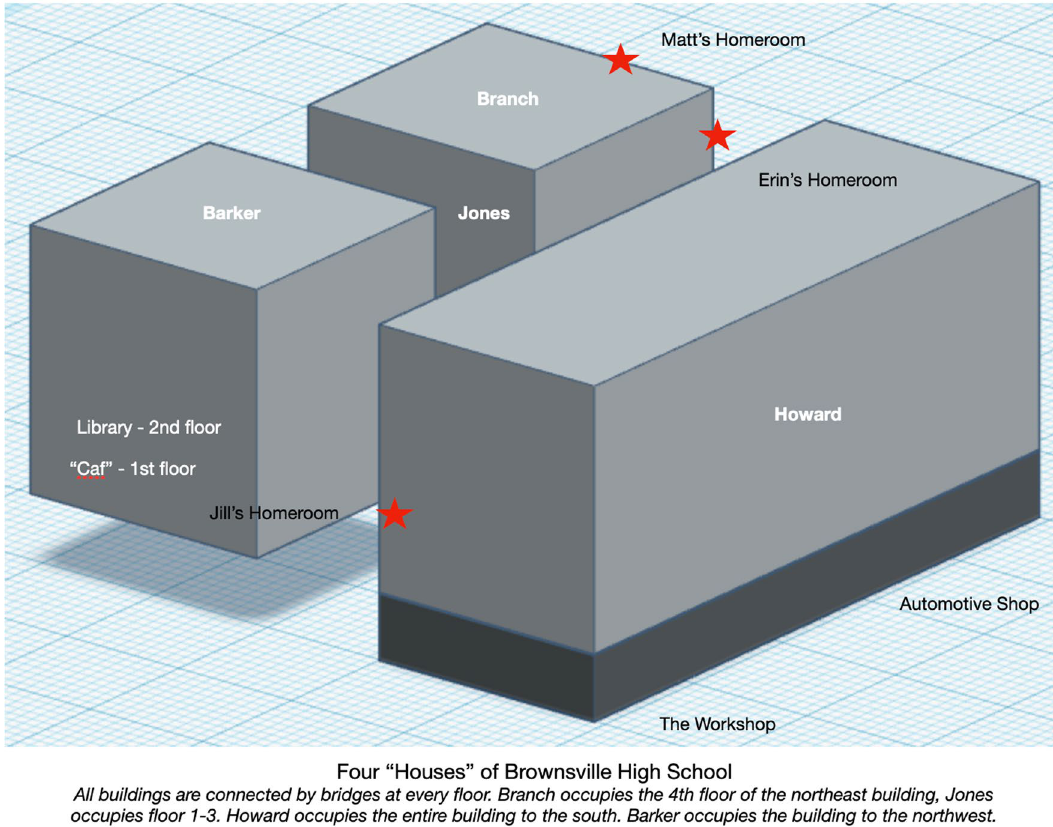
Fig. 1 Schematic representation of Brownsville High School’s four buildings, showing the relative position of key locations in the